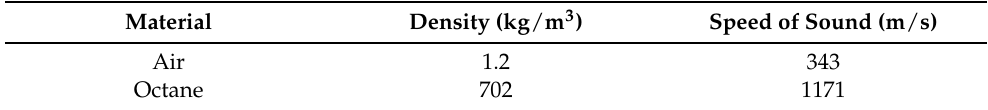
Table 2. Interior material properties used for simulating backscattered responses. Data from the Engineering Toolbox [35].